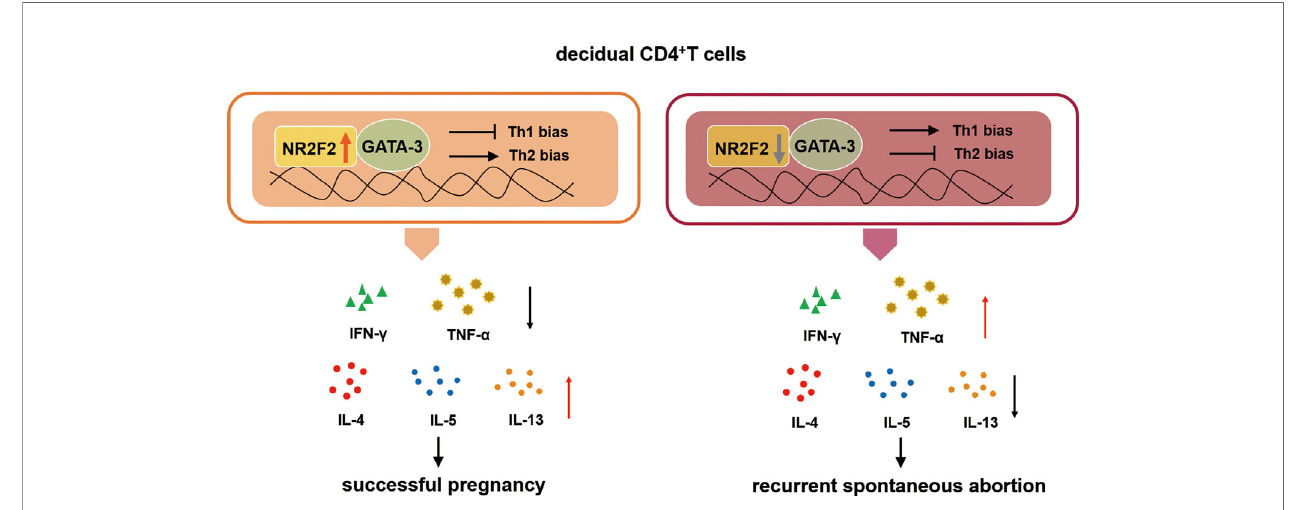
FIGURE 6 | The role of NR2F2 in mediating decidual Th2 bias and pregnancy maintenance. The transcription factor NR2F2 is dominantly expressed in decidual CD4 + T cells during early pregnancy. The upregulated expression of NR2F2 promotes Th2 differentiation with the inhibition of Th1 skewing via binding GATA-3. The population of decidual NR2F2 + CD4 + T cells displays Th2-like phenotype, producing higher level of Th2 cytokines with lower level of Th1 cytokines. In RSA patients, the expression of NR2F2 in decidual CD4 + T cells is decreased, failing to induce Th2 differentiation via binding